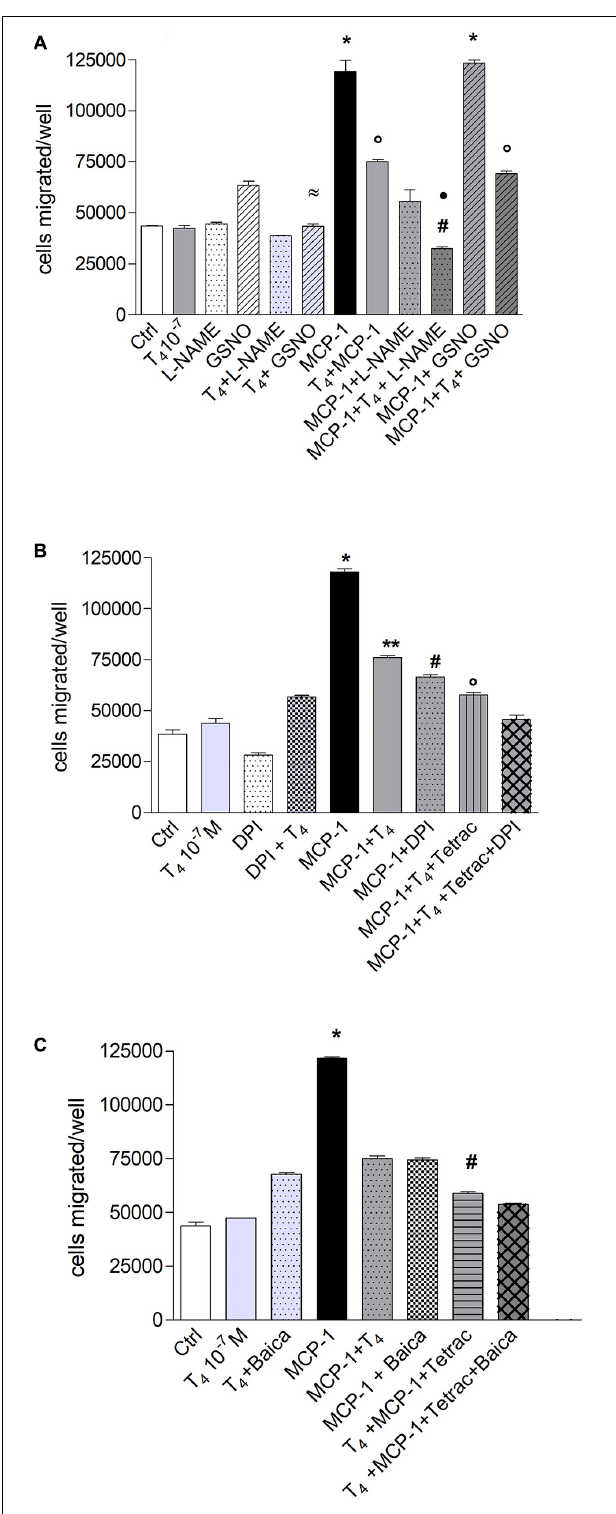
FIGURE 7 | Possible effects of reactive oxygen species (ROS) and reactive nitrogen species (RNS) in the signal transduction of thyroid hormone inhibition of monocyte chemoattractant protein 1 (MCP-1)-mediated migration in THP-1